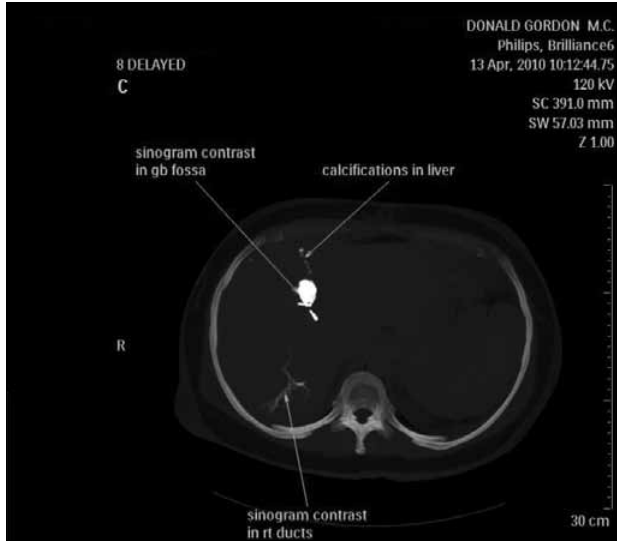
Fig. 2. Reconstructed CT sinogram with contrast in the gallbladder fossa and right posterior sectoral ducts (note surgical clips in the gallbladder